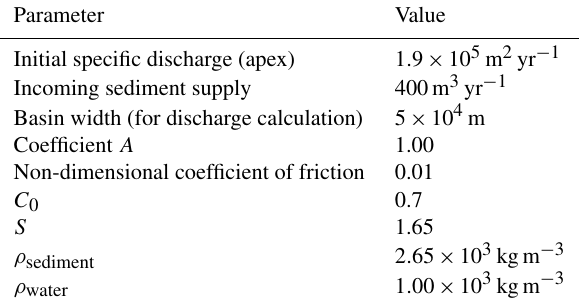
Table 2. Sediment diffusion calculation